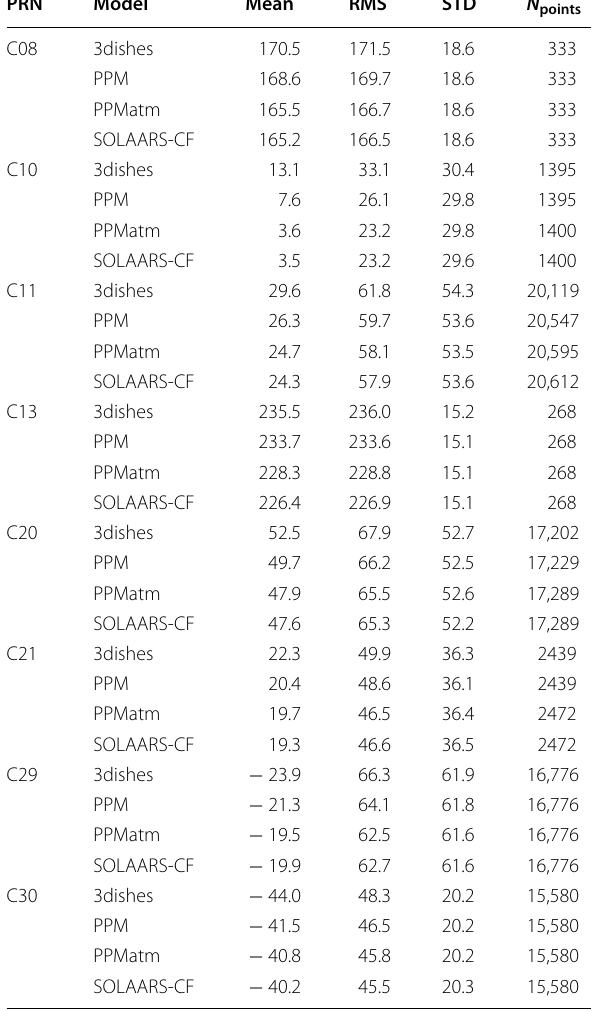
Table 5 SLR validation results of four shadow models for different satellites ( N points : Number of observation points; unit: